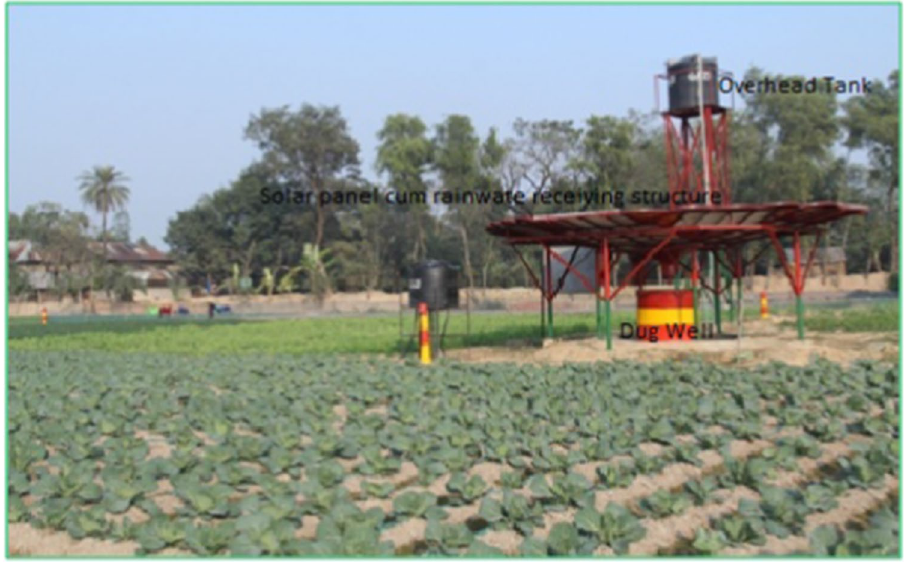
Fig. 7 Dug Well along with overhead tank and solar panel cum rain water